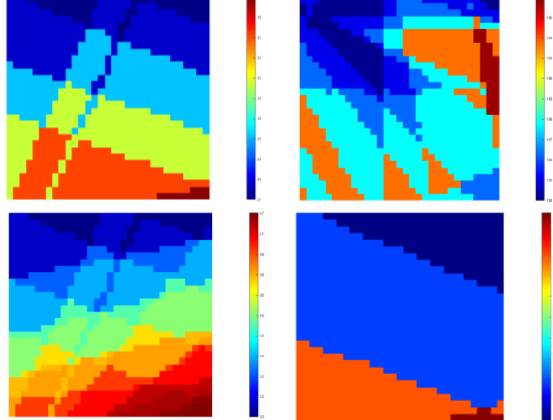
Figure 13. Image multiplicity for test area 1 and for the scenarios 1 (top-left), 2, 3 and 5,